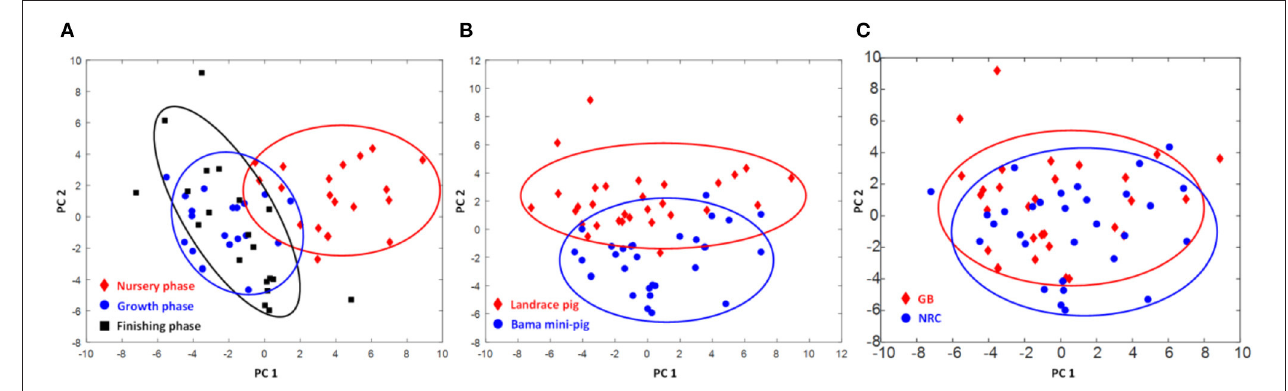
FIGURE 2 | Score plots of metabolome of psoas major muscle of pigs. (A) Different physiological stages (PC1 = 0.266, PC2 = 0.253, Q 2 = 0.368); (B) different breeds of pigs (PC1 = 0.253, PC2 = 0.519, Q 2 = 0.368); (C) different diets (PC1 = 0.266, PC2 = 0.253, Q 2 =